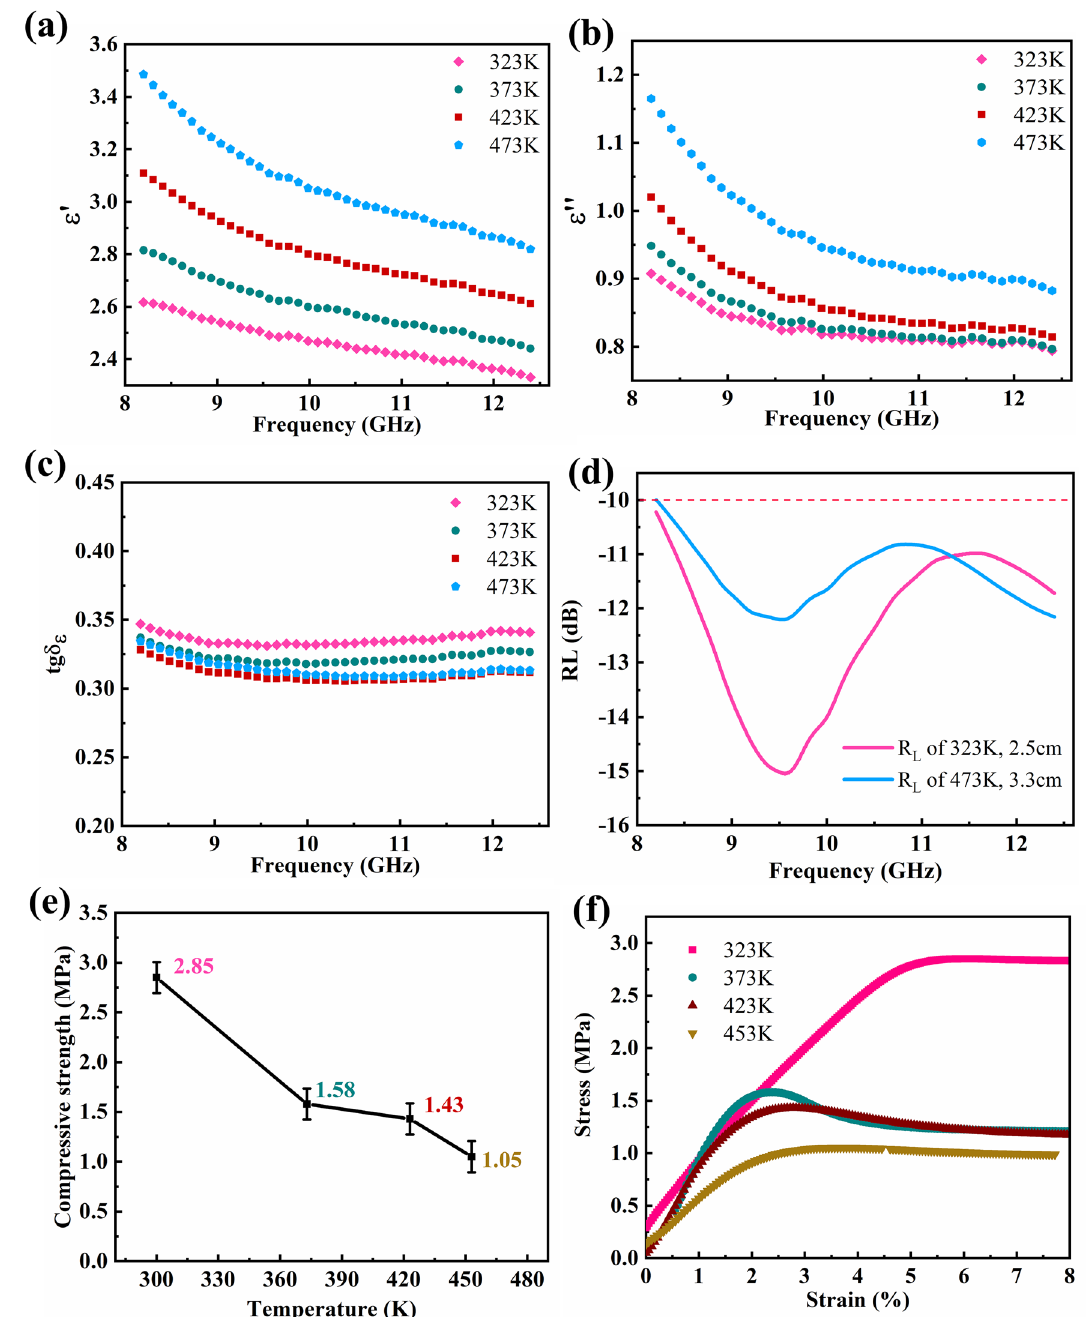
Fig. 6 a Dielectric real part, b dielectric imaginary part, c dielectric loss tangent value, d R L curves at different temperature, e compressive strength and f typical stress–strain curves of CP-4 with different